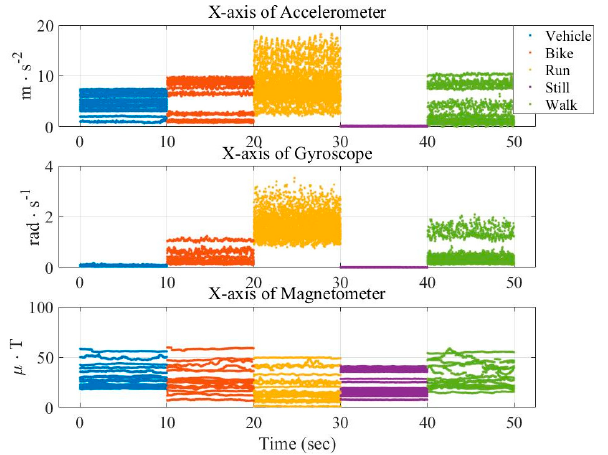
Figure 2. Distribution of averaged data from three sensors (x-axis) in the transportation mode.